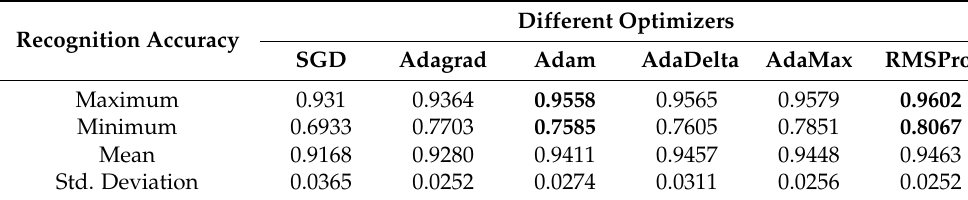
Table 5. In this table, we report the results in term of maximum, minimum, mean, and standard deviation recognition accuracy obtained with NA-6 on ISIDCHAR when the system trained for 50 epochs with the different optimizers. The best scores are in bold.